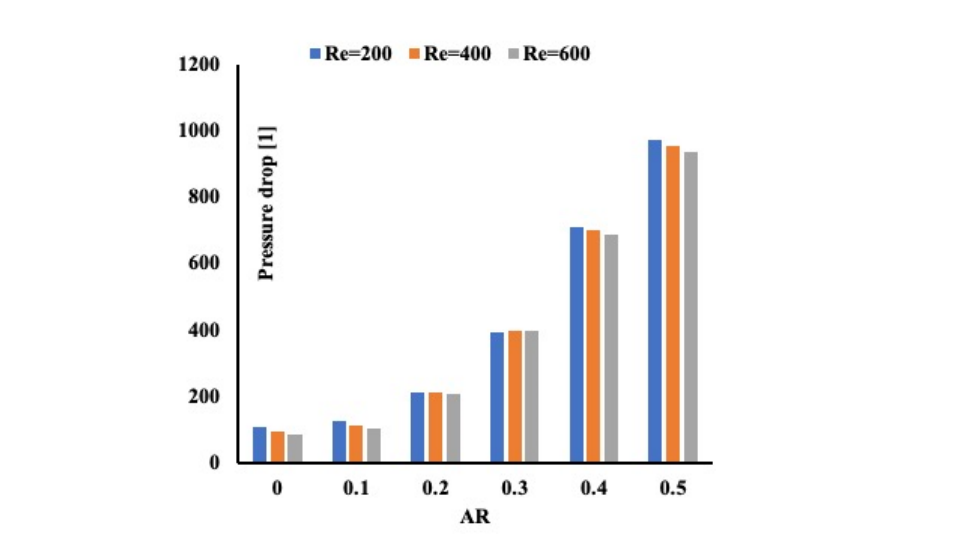
Figure 8. Pressure drop variation as a function of Reynolds number and aspect ratio.